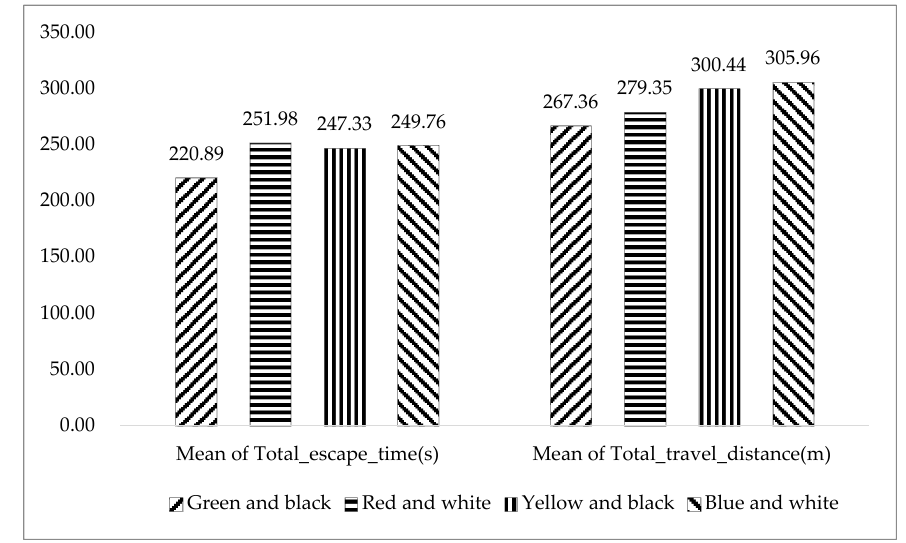
Figure 7. Mean of Total_escape_time and mean of Total_travel_distance in the four color groups.